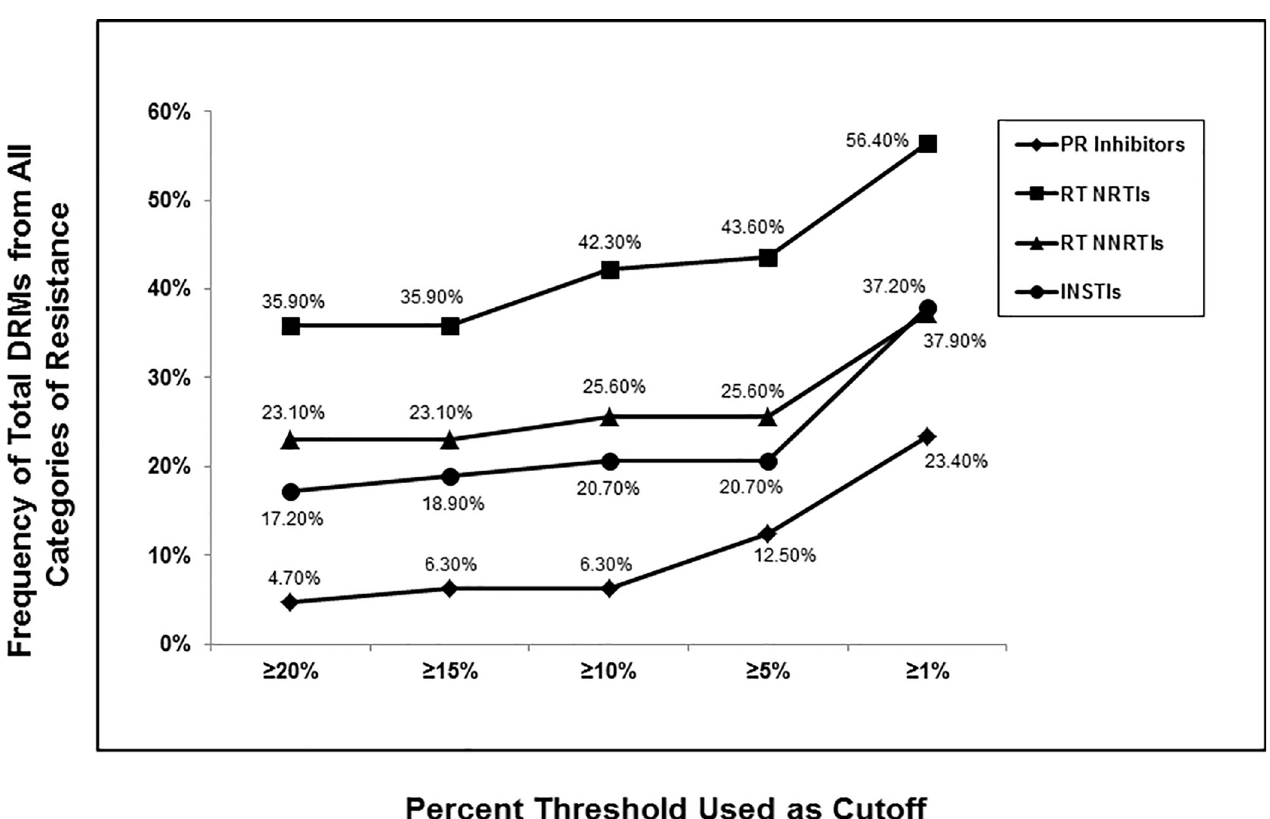
Fig 2. Impact choice in frequency cutoff had on number of total DRMs detected. Frequency of the total numbers of DRMs, including Potential Low-level, Low-level, Intermediate and High-level resistance detected for Protease Inhibitors (PIs) (n = 64), Nucleoside Reverse Transcriptase Inhibitors (NRTIs) and Non-Nucleoside Reverse Transcriptase Inhibitors (NNRTIs) (n = 78) and Integrase Strand Transfer Inhibitors (INSTIs) (n = 58) was determined across 5 different % frequency cutoffs including � 20%, � 15%, � 10%, � 5% and � 1% using the Stanford HIVdb program from HyDRA Web